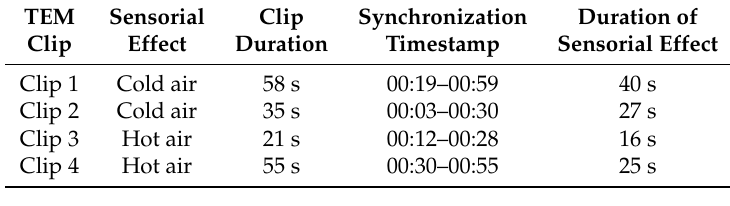
Table 2. Synchronization timestamp and tactile effect duration of TEM clips used in this study.